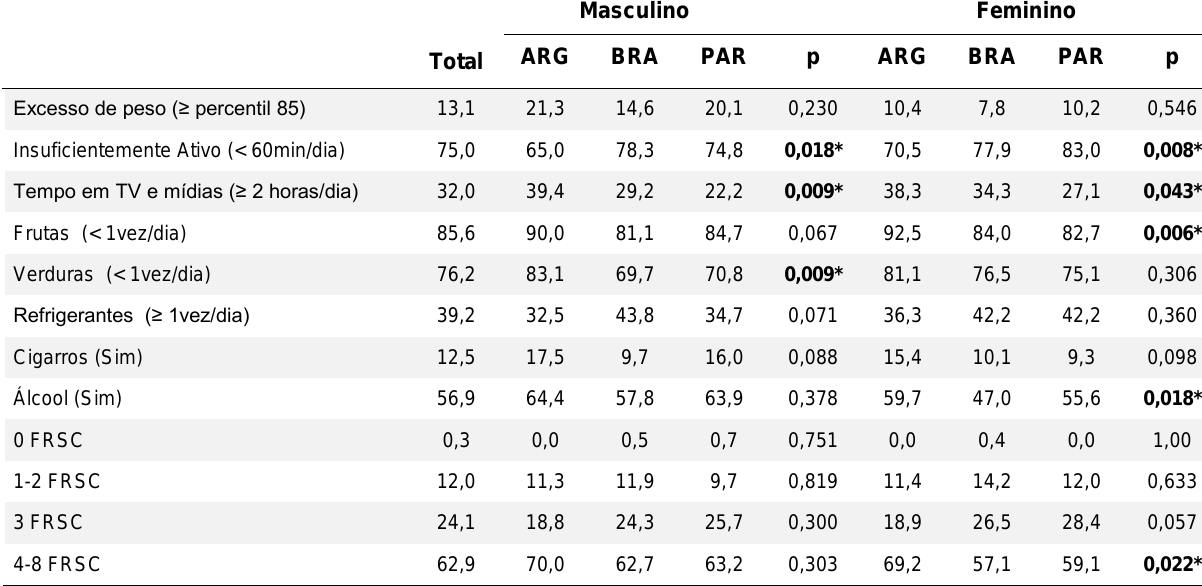
Tabela 3. Prevalência de adolescentes expostos aos fatores de risco à saúde cardiovascular na região da Tríplice Fronteira, de acordo com o sexo e a